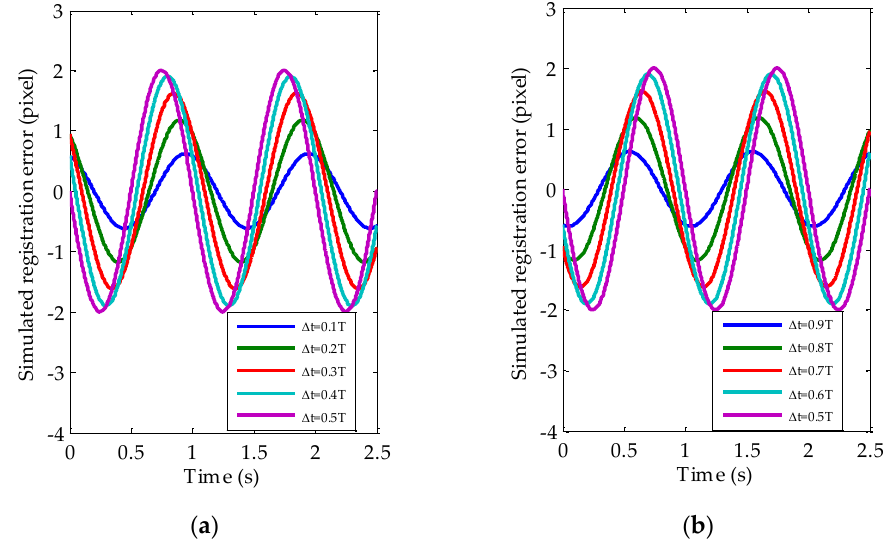
Figure 3. The simulated registration error curves caused by satellite jitter (SJ) at different imaging time intervals: ( a ) ∆ t = 0.1 T ,0.2 T ...0.5 T ; ( b ) ∆ t = 0.5 T ,0.6 T ...0.9 T